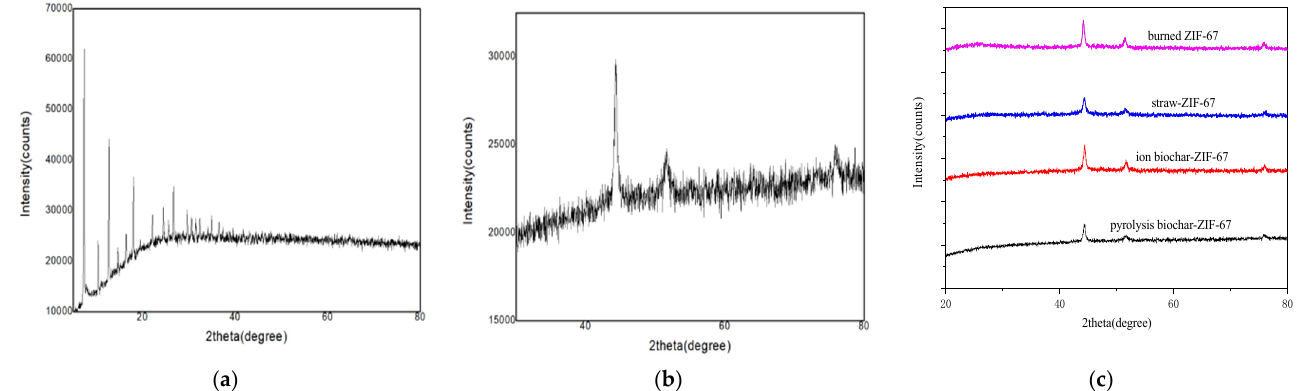
Figure 1. The XRD diffraction pattern of the prepared ZIF-67 sample ( a ), ZIF-67 after carbonization ( b ), and the biochar–MOF composites prepared by different methods ( c ).